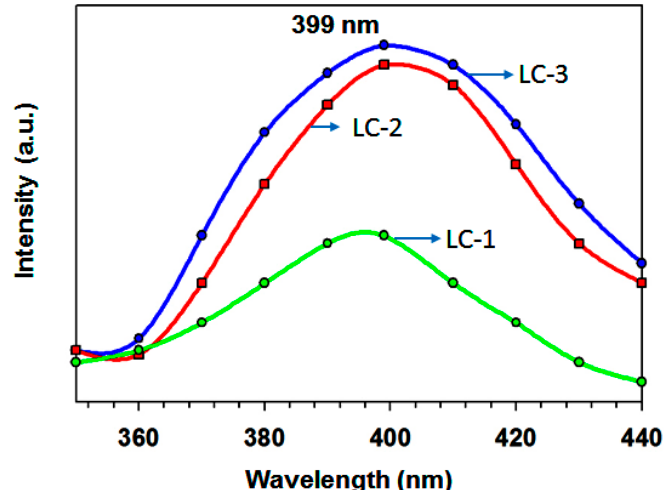
Figure 8. Photoluminescence spectra (excited by λ ex = 280) of ( a ) LC-1, ( b ) LC-2 and ( c ) LC-3 samples at room temperature.